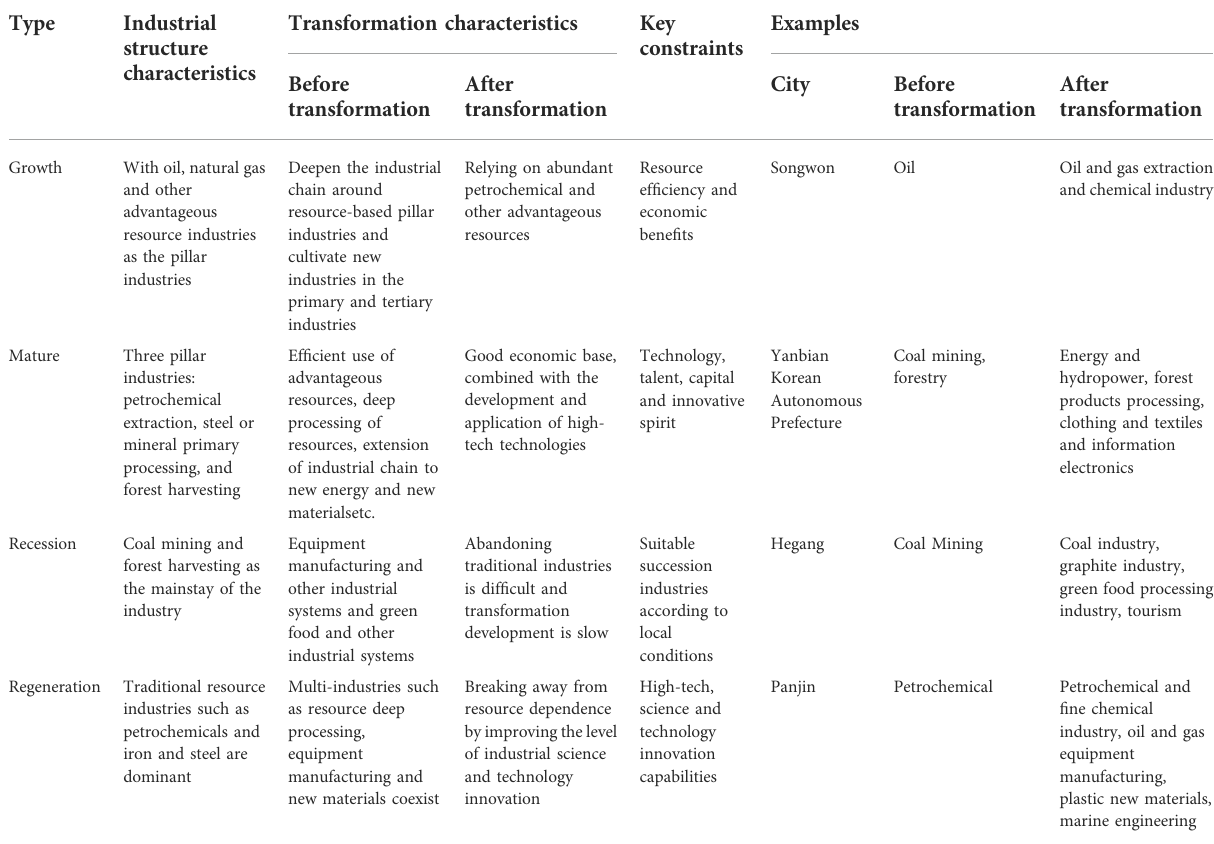
TABLE 3 Industrial characteristics and pillar industries of four types of